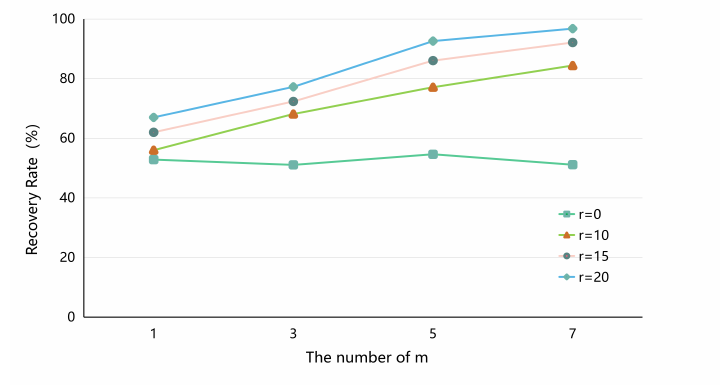
Figure 9. Multi-path transmission success